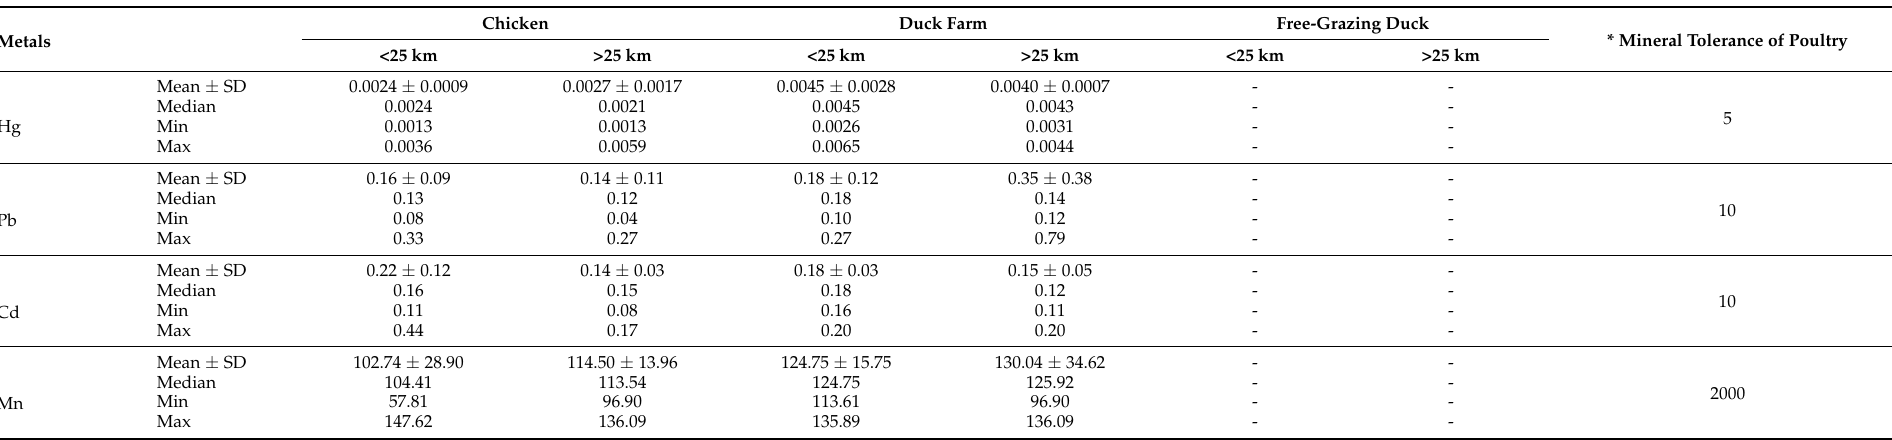
Table 4. Mean ± SD, the median, minimum, and maximum values of Hg, Pb, Cd, and Mn concentrations in poultry feed (mgkg − 1 dry weight).